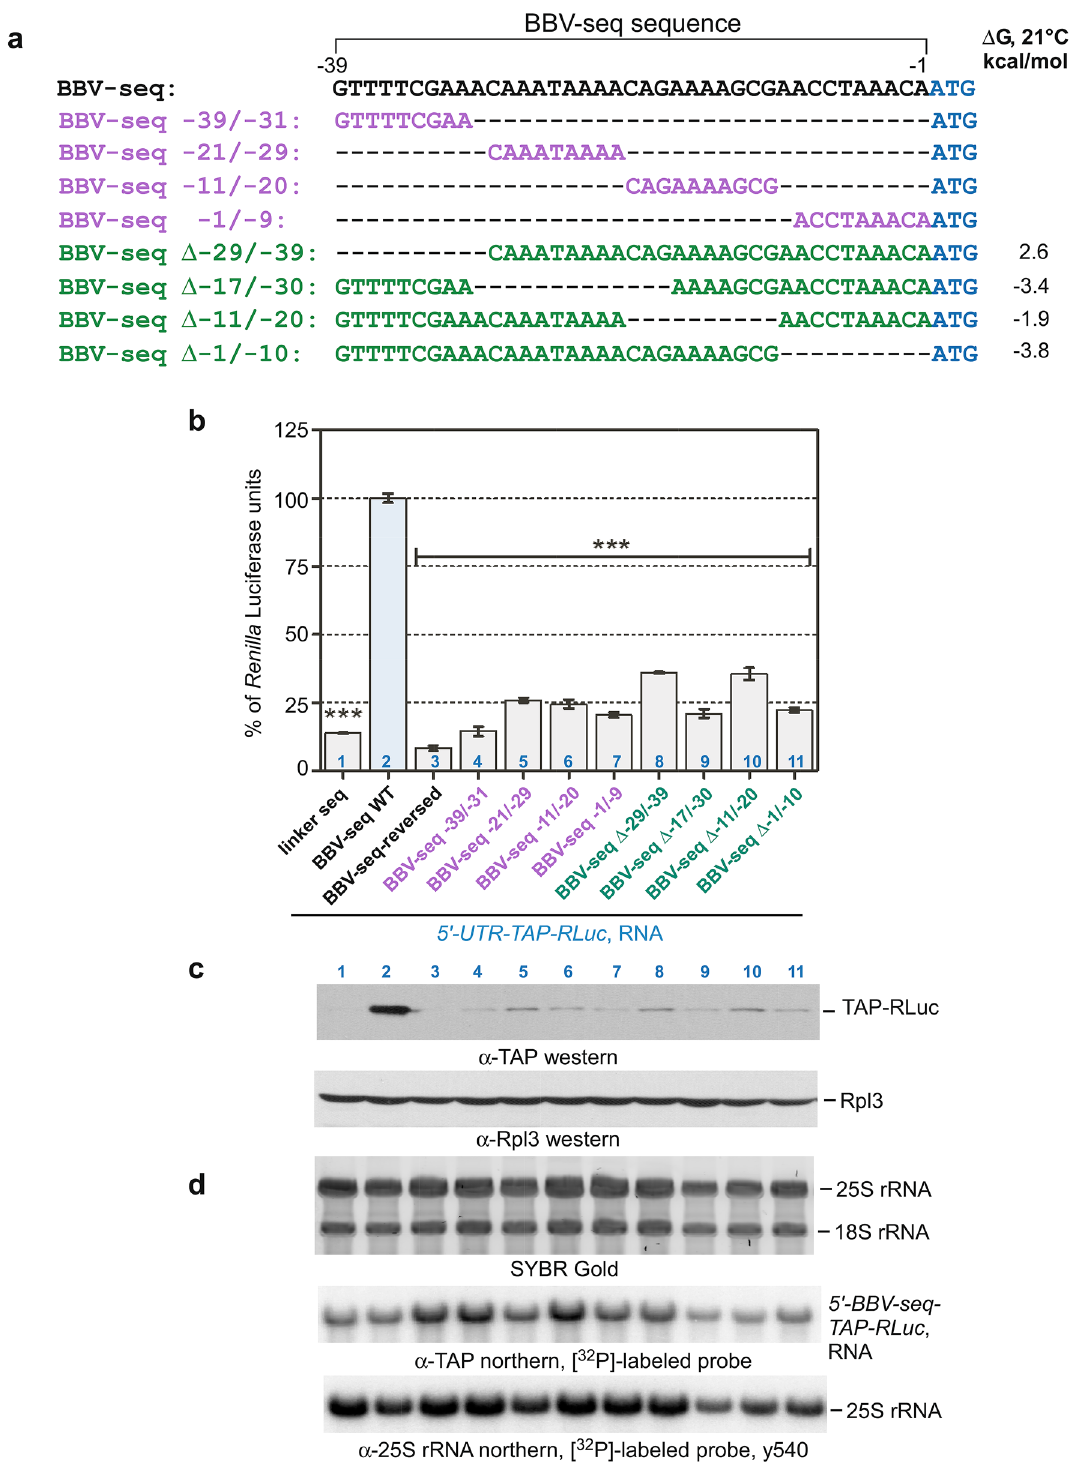
Figure 3. BBV-seq mutational analysis reveals that the entire sequence is required for efficient protein translation in cell-free reactions. ( a ) Sequence alignments of BBV-seq wild-type and deletion mutants. Gibbs energies (∆G) at 21 °C are shown on the right. ( b – d ). RNAs containing indicated 5 ′ -UTR upstream of TAP- RLuc reporter were used in cell-free translation reactions as described in Fig. 1d. ( b ) Reaction products were analyzed by a Renilla luciferase assay and data are shown as % of Renilla luciferase units derived from the reaction containing BBV-seq-WT-TAP-RLuc mRNA. Error bars represent standard error of the mean (SEM) of three individual experiments; “***” denotes P -value < 0.001. ( c , d ) Proteins and RNA were extracted from the luciferase reactions and further characterized by ( c ) western blots using anti-TAP or anti-Rpl3 antibodies and ( d ) northern hybridizations using TAP - and 25S rRNA-specific probes. SYBR Gold staining of RNA prior to transfer is shown in ( d